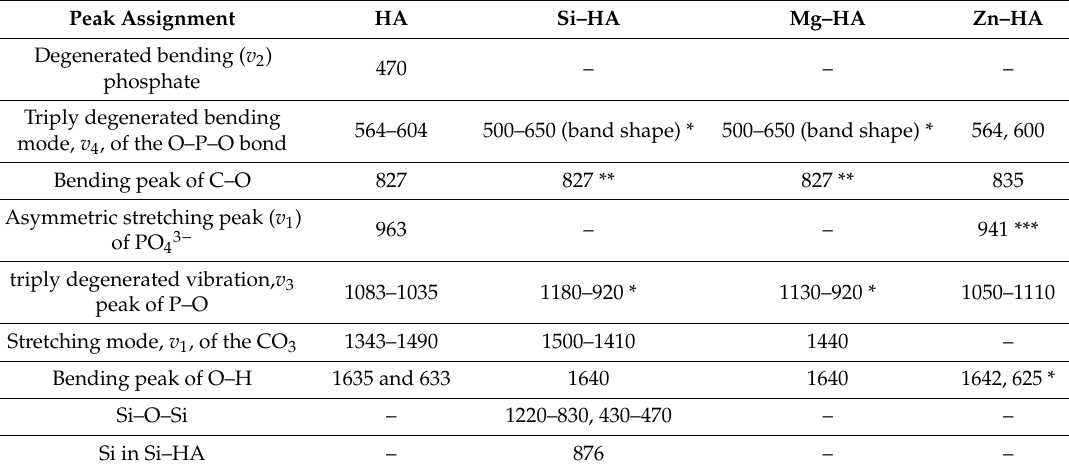
Table 2. FTIR bands and peak assignments as observed in this study.